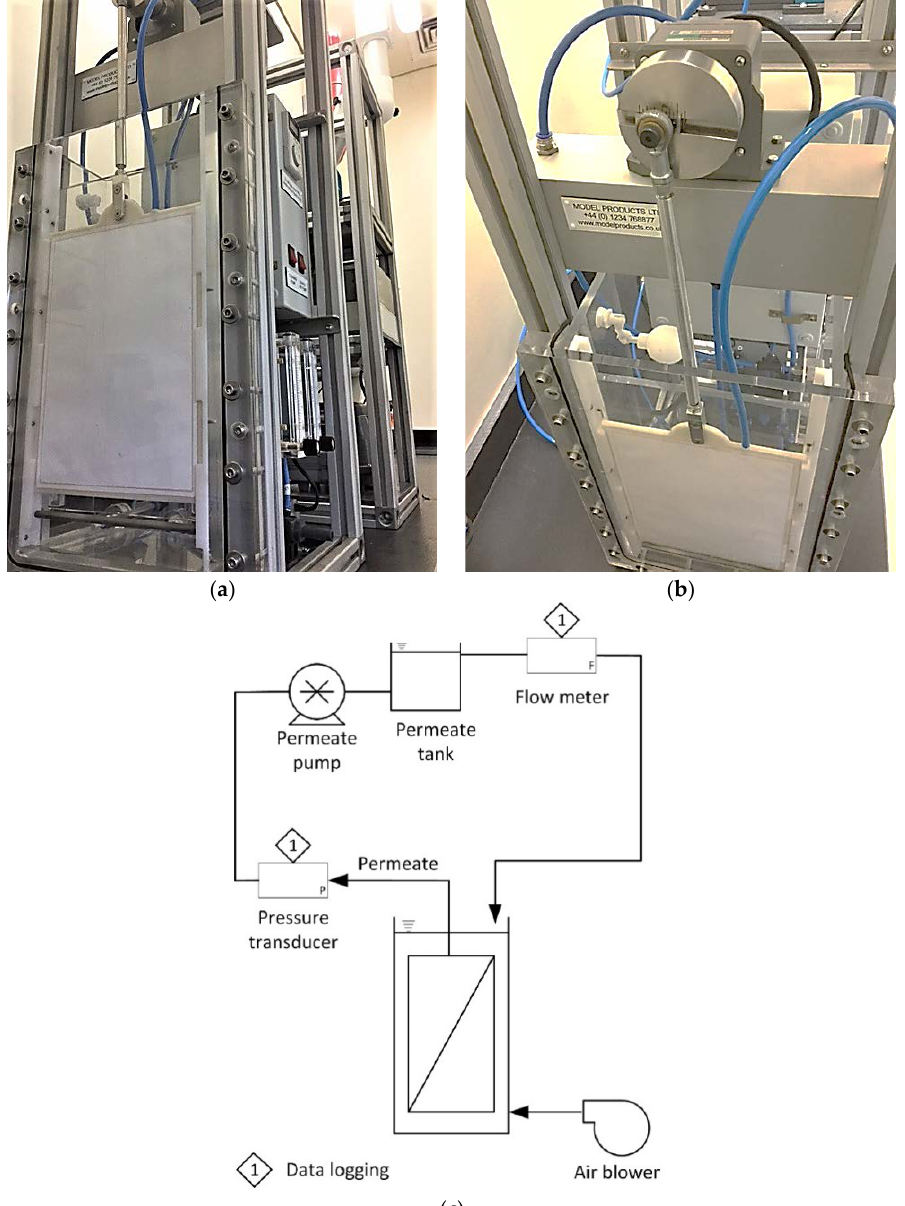
Figure 2. The membrane bioreactor (MBR) test cell, ( a ) membrane and channel; ( b ) motor and crank; and ( c ) schematic.